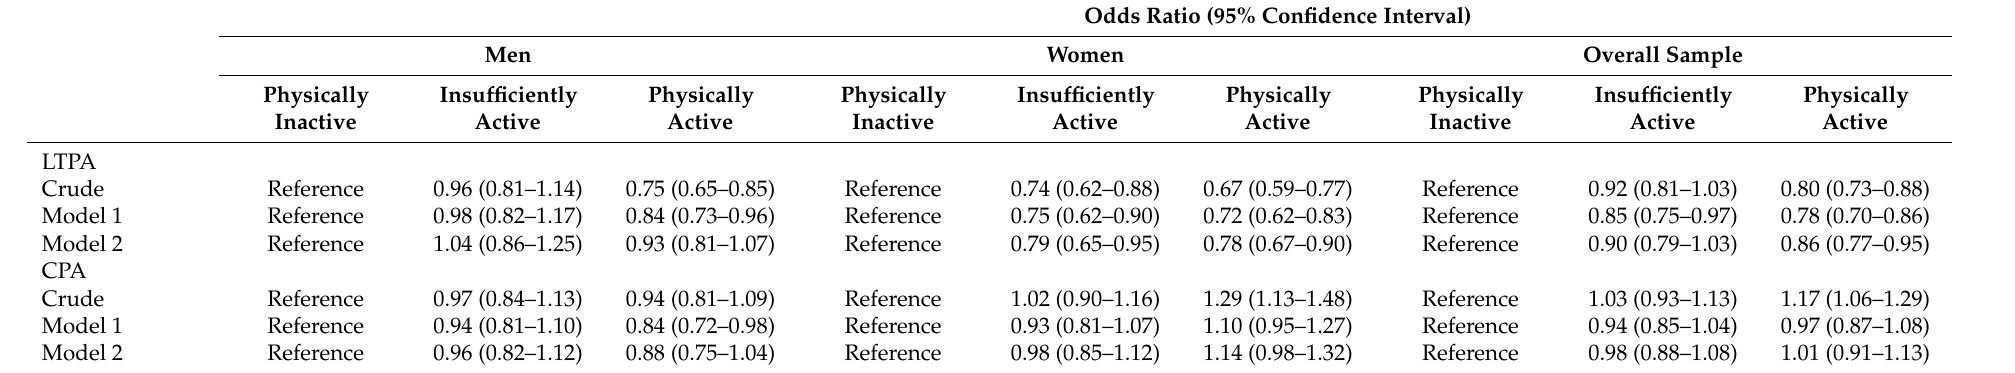
Table 4. Association of physical activity at leisure time and at commuting with pre-diabetes in baseline participants of ELSA-Brasil study (n = 11,797). Odds Ratio (95% Confidence